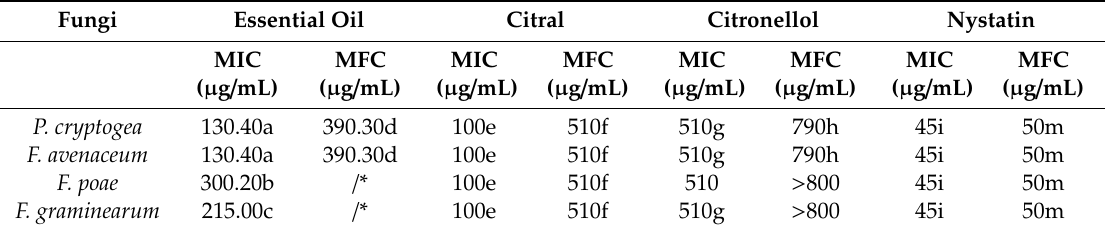
Table 2. Minimal inhibitory concentration (MIC) and minimal fungicidal concentration (MFC) of Vepris macrophylla essential oil, citral and